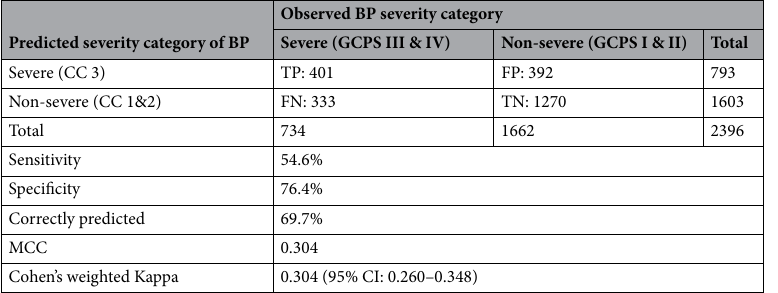
Table 3. Evaluation of the predicted severity of BP with self-reported GCPS grades. GCPS Graded chronic pain grade 27 based on a self-questionnaire at enrolment, CC Chronicity class 36 based on administrative claim data, TP True positive were actual severe BP cases that were correctly predicted as severe, TN True negative were actual non-severe BP cases that were correctly predicted as non-severe, FP False positive were actual non- severe cases of BP that were wrongly predicted as severe, FN False negative were actual severe BP cases that were incorrectly predicted as non-severe.